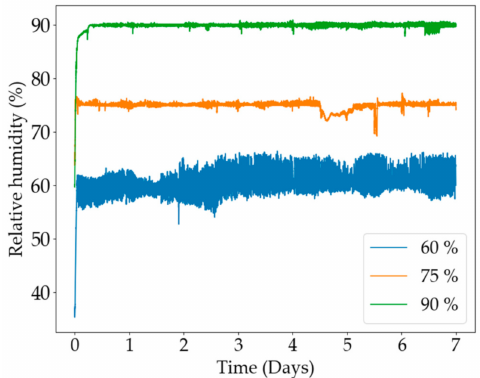
Figure 6. The on/off humidity control data for the three different humidity